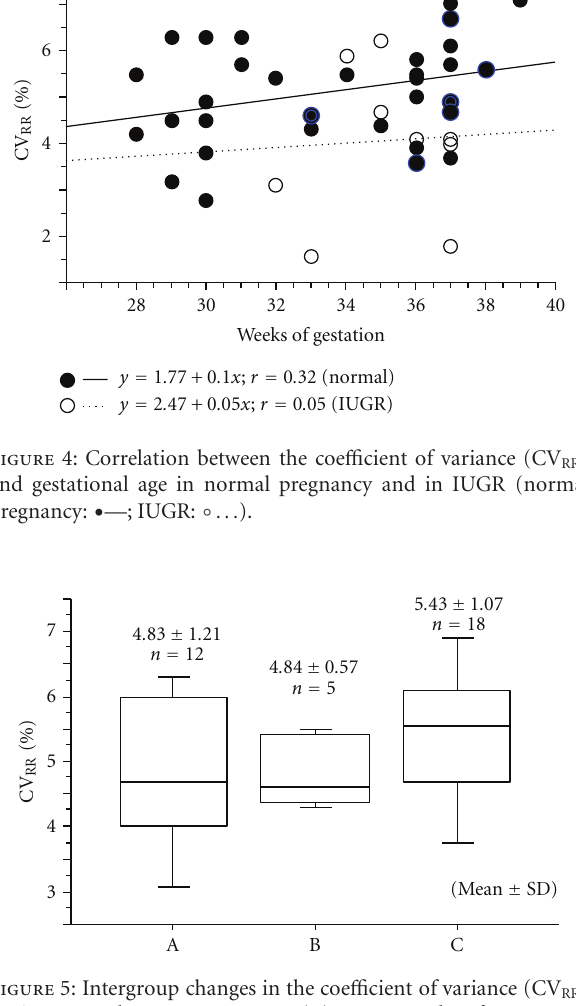
month of pregnancy); Group (C): 36–40 weeks of pregnancy (10th month of pregnancy).